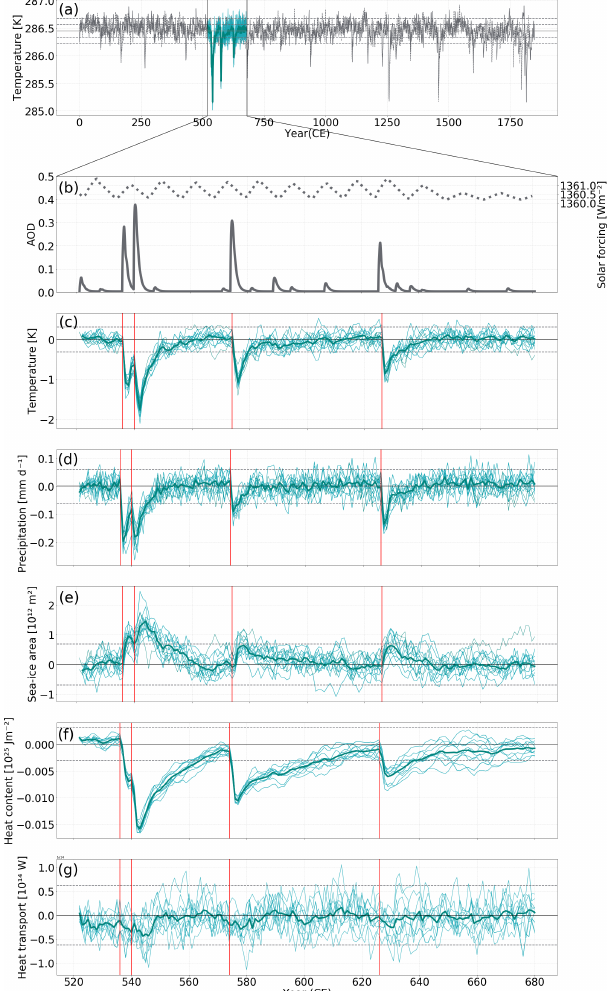
Figure 2. Time series of (a) NH 2m air temperature for the two past2k experiments as well as (b) global AOD volcanic forcing and solar forcing. Time series for the MPI-ESM 521–680CE ensem- ble runs of (c) NH 2m air temperature, (d) NH total precipitation, (e) Arctic sea-ice area, (f) global ocean heat content for the upper 700m, and (g) Atlantic ocean heat transport at 60 ◦ N. All variables are given as anomalies with respect to 1–1850CE. The timing of the volcanic eruptions in the study period (520–680CE) is represented by a red line. Ensemble runs are blue, and the ensemble mean is the thick blue line. The gray dashed lines indicate the 2 σ value of the control